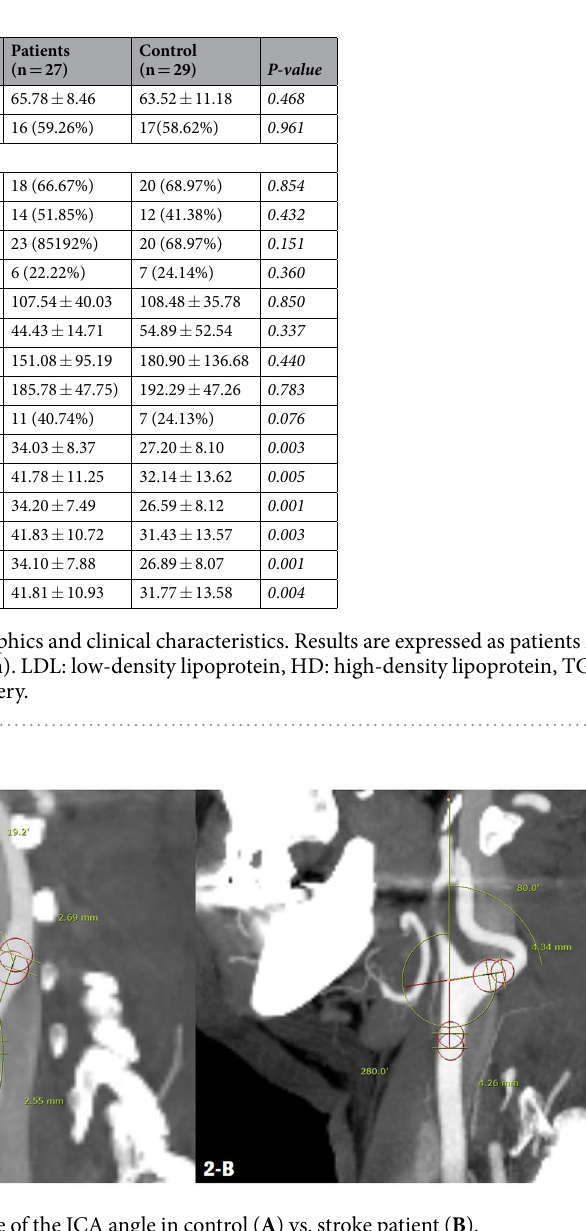
Figure 2. Compare of the ICA angle in control ( A ) vs. stroke patient ( B